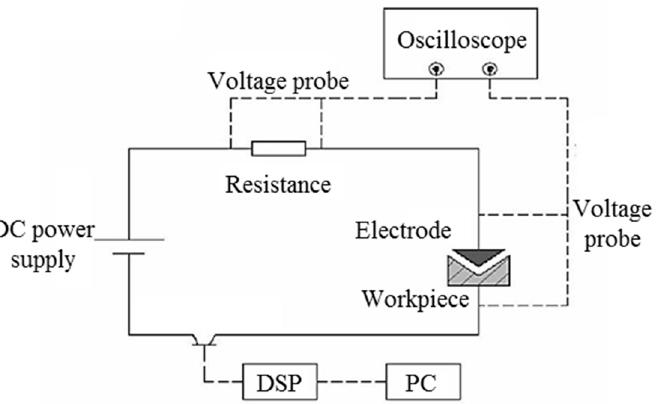
Figure 4. The schematic diagram of the single-pulse discharge machining system [2].